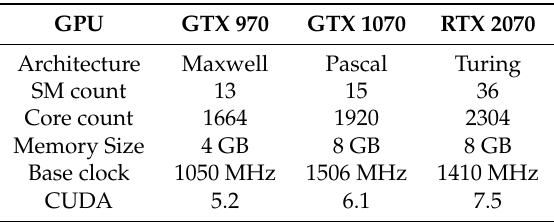
Table 4. Target CUDA-enabled NVIDIA GPUs.